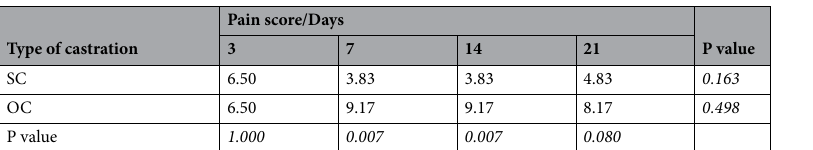
Table 2. Mean rank of pain score of donkeys subjected to subcapsular (SC) and open castration (OC) techniques. Differences were considered statistically significant for P < 0.05. The pain score differences were determined using the Kruskal–Wallis nonparametric test due to lack of normality